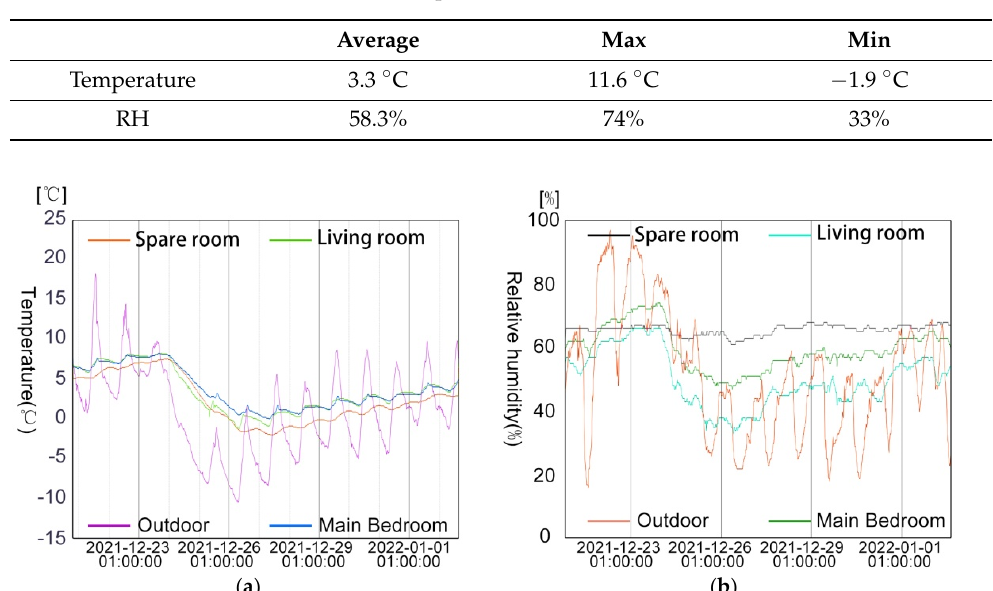
Table 7. Statistics of indoor environmental parameters in summer.